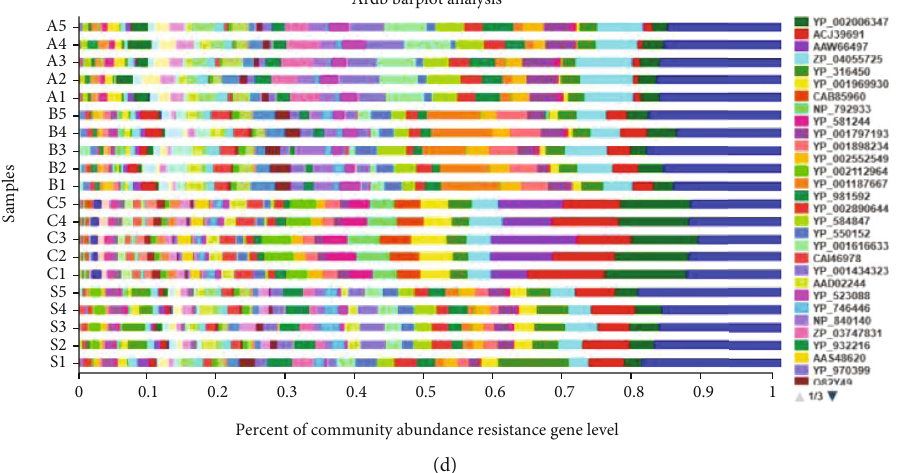
Figure 4: (a) Percentage of the community ’ s overall abundance based on antibiotic type ARG types. (b) PCoA of the ARGs. (c) Percent of community abundance on antibiotic class level. (d) Percent of community abundance on ARG antibiotic resistance gene